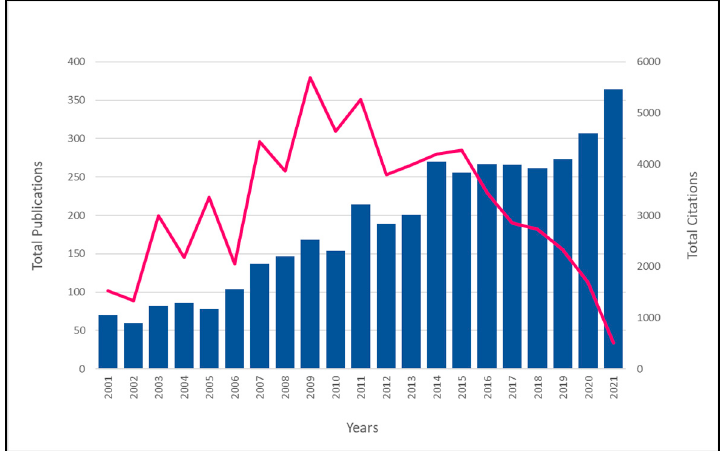
Figure 3. Research trends